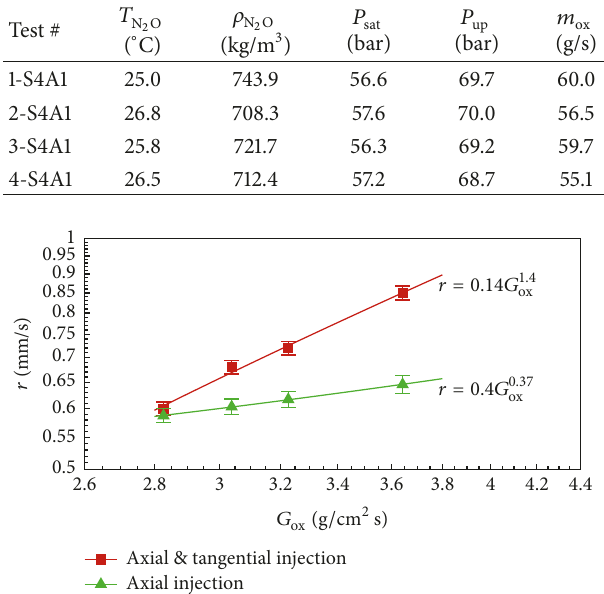
Table 5: Oxidizer mass flow rate.